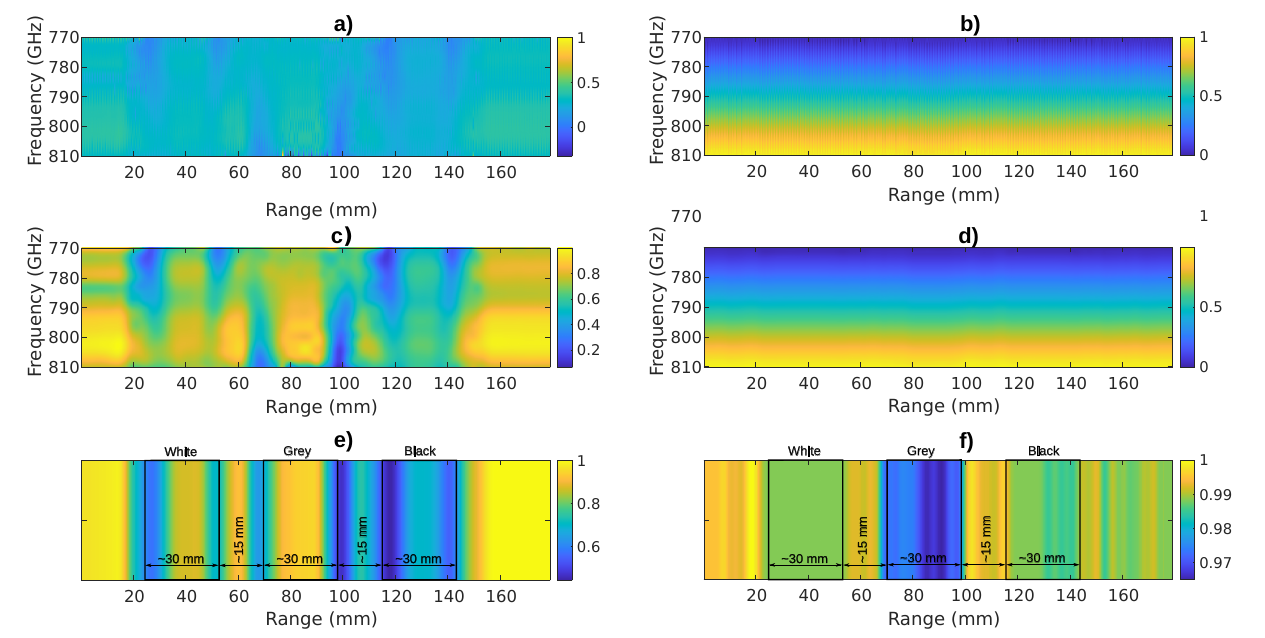
Figure 13. Spectrograms and images for acquisitions in the frequency range 770–810 GHz: ( a ) Peak envelope spectrogram. ( b ) Unwrapped phase spectrogram. ( c ) Peak envelope spectrogram processed using GSF, ( d ) Unwrapped phase spectrogram processed using GSF. ( e ) Compressed 1D intensity image with marked plastic plates‘ positions. ( f ) Compressed 1D phase image with marked plastic plates’ positions.